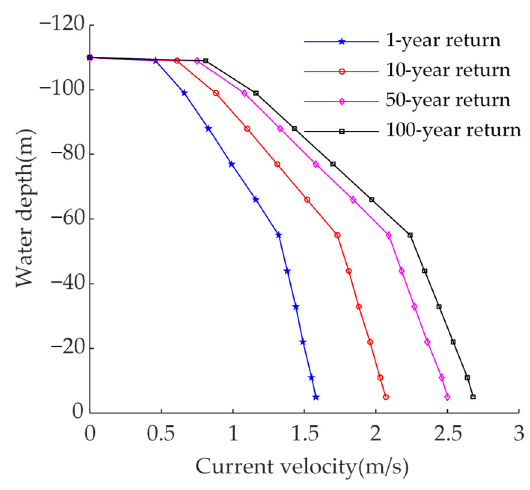
Table 4. Environmental parameters for the hydrodynamic basin test.